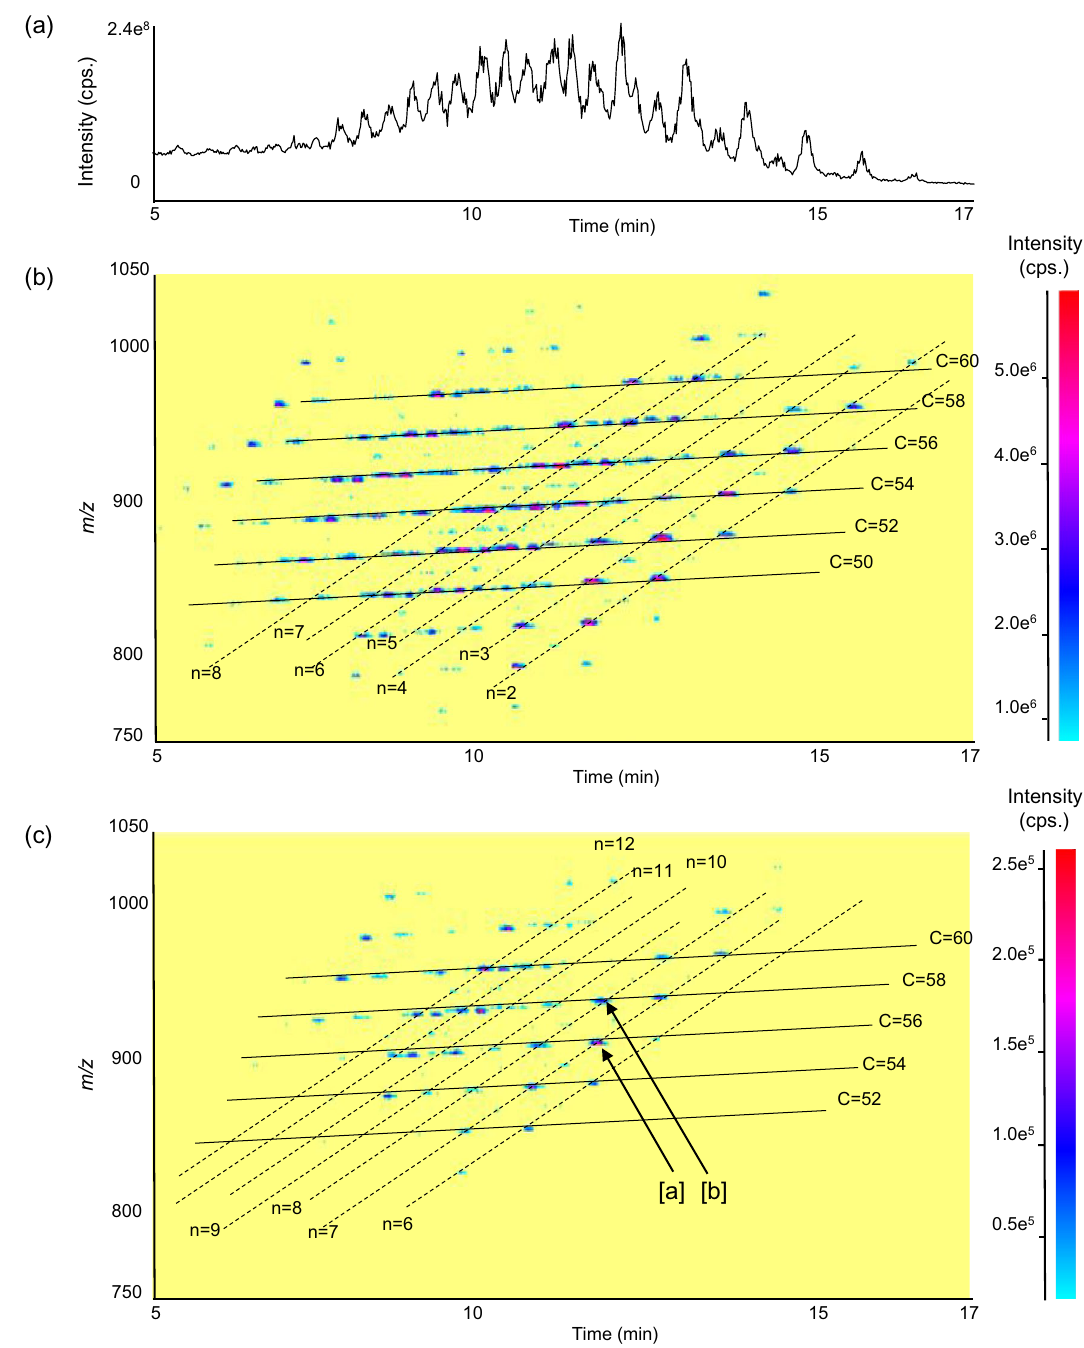
Figure 2. ( a ) LC–MS chromatogram of neutral lipid fraction extracted from mackerel. ( b ) 2D map of Q1 scan of neutral lipid fraction extracted from mackerel. ( c ) 2D map of NL scan of neutral lipid fraction extracted from mackerel for the NL of 328.2 Da. The 2D maps in this figure were generated by using Analyst software (ver. 1.6.3) under AB SCIEX Software